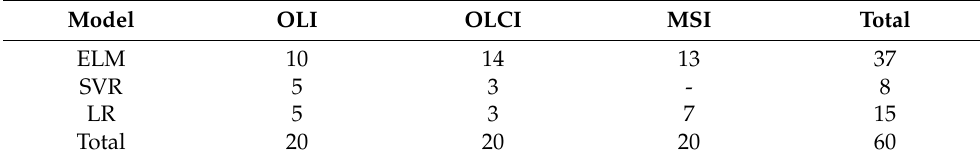
Figure 6. Comparison of estimated Chlorophyll-a (Chl-a, column ( a )), Turbidity (column ( b )), total suspended matter (TSM, column ( c )) and Secchi disk depth (SDD, column ( d )) by sensor. Individual estimations by lake are displayed on each figure: Operational Land Imager (OLI) (top), Ocean and Land Color Instrument (OLCI) (center) and Multi Spectral Instrument (MSI) (bottom). Table 4. Model occurrence in every sensor as a result of better predictive